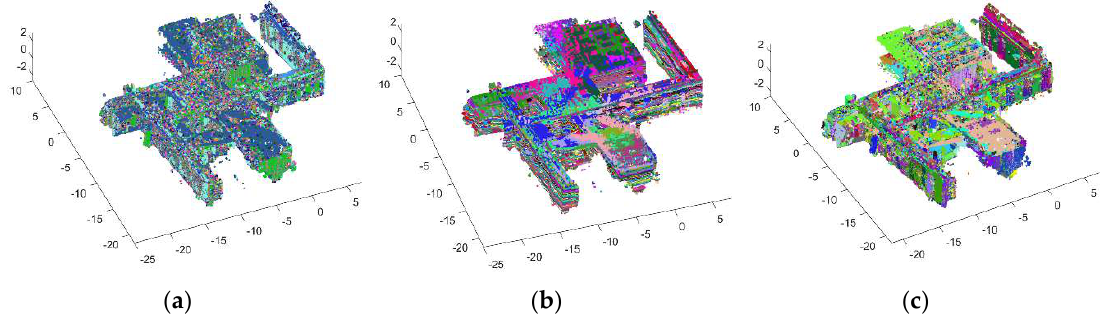
Figure 2. 3D point cloud segmentation: ( a ) Region-based; ( b ) model based; and ( c ) hybrid approach.